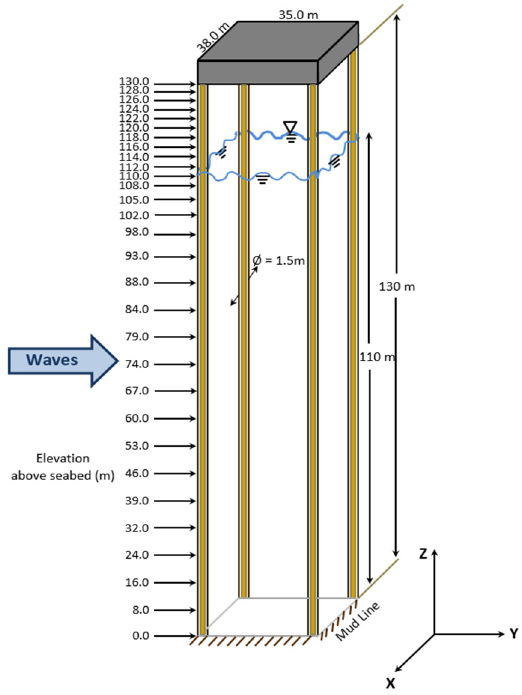
Figure 1. Schematic diagram of the offshore structure.